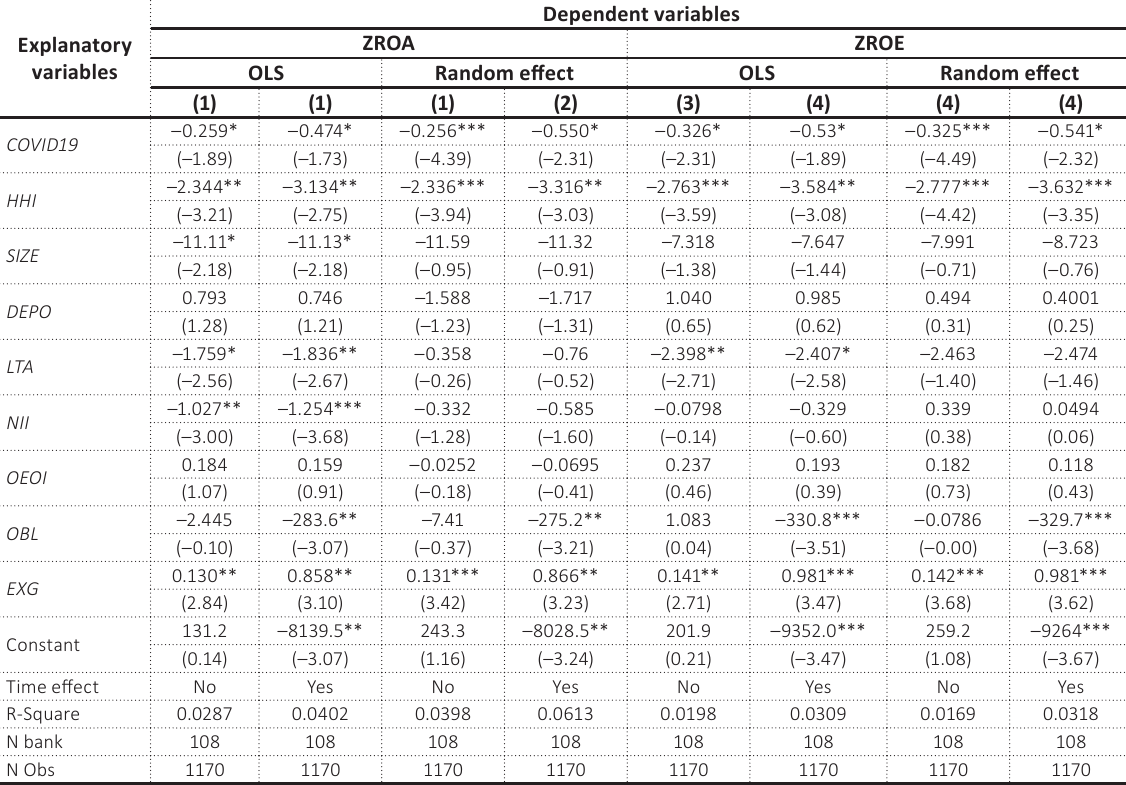
Table 8. COVID-19 and bank stability – robustness checks with alternative measurement of econometric